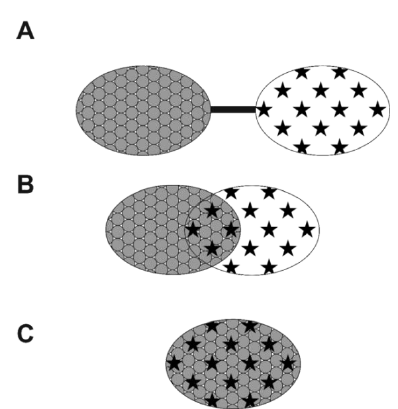
Figure 1. Strategies to design multi-target ligands. ( A ) linking of pharmacophores; ( B ) overlapping of pharmacophores; ( C ) integration of pharmacophores.